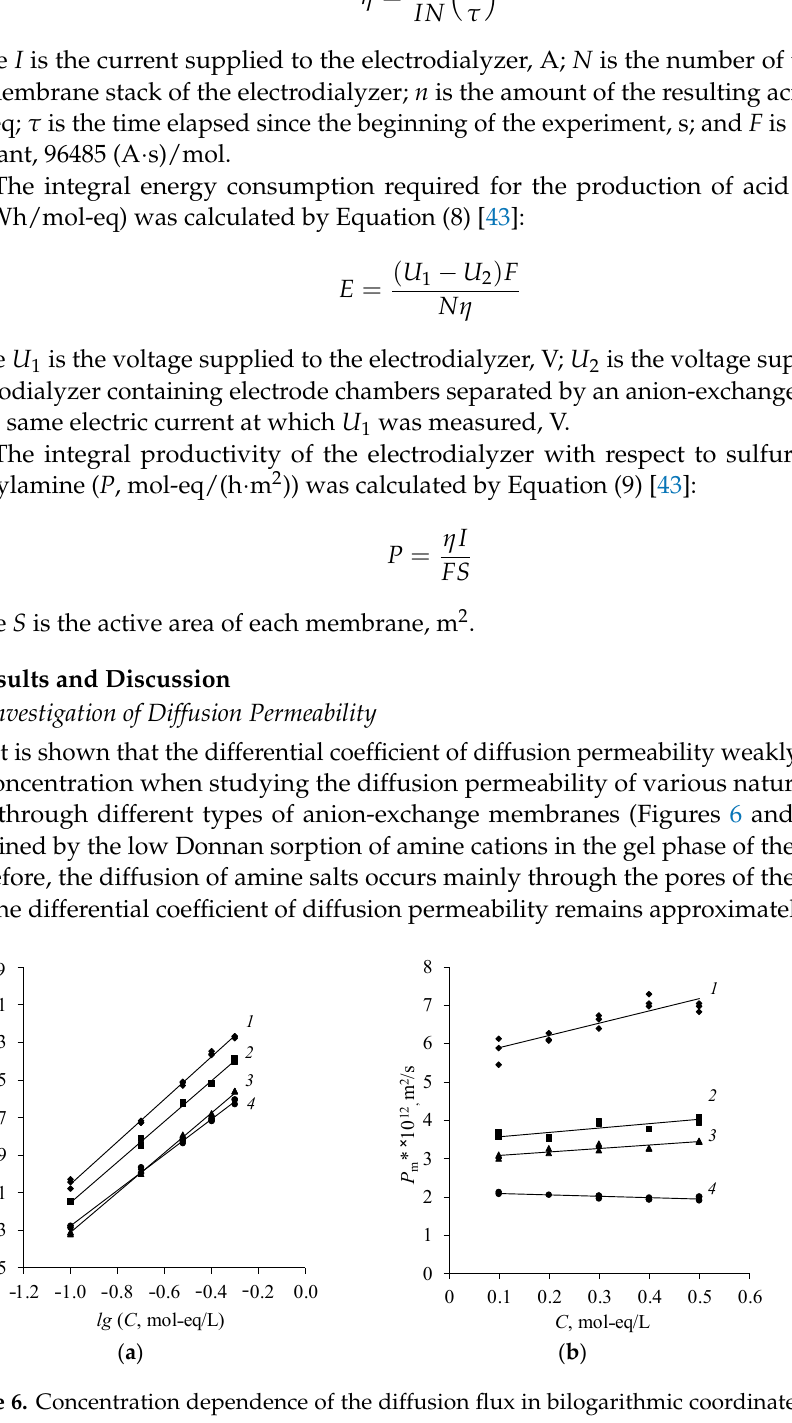
( b ) Figure 7. Concentration dependence of the diffusion flux in bilogarithmic coordinates ( a ) and the differential coefficient of diffusion permeability ( b ) of amine salts through the anion-exchange mem- brane Ralex AMH. 1 —(MA) 2 H 2 SO 4 , 2 —(DMA) 2 H 2 SO 4 , 3 —EDAH 2 SO 4 , 4 —(DEA) 2 H 2 SO 4 . The MA-40L membrane has the greatest diffusion permeability (Figure 6). This is due to the fact that the lavsan reinforcement rigidly fixes the membrane; therefore, when it swells, a large number of macropores are formed, through which the diffusion transport of diethylammonium sulfate occurs. The membrane MA-40 has the lowest permeability to diethylammonium sulfate. Nylon is more elastic than lavsan, thus the fraction of pores does not increase with the swelling of the MA-40 membrane. Moreover, the MA-40 mem- brane has the highest exchange capacity among the presented membranes [8,44]. There is a greater Donnan exclusion of cations (cations of amines) from the gel phase of the mem- brane under study with an increase in the exchange capacity of the membrane, which in turn prevents the diffusion flux. The diffusion transport of amine salts of various natures decreases with an increase in their molar mass. Therefore, the salt of the simplest representative of aliphatic amines— methylamine—diffuses through the anion-exchange membrane about five times better than diethylammonium sulfate (Figure 7).